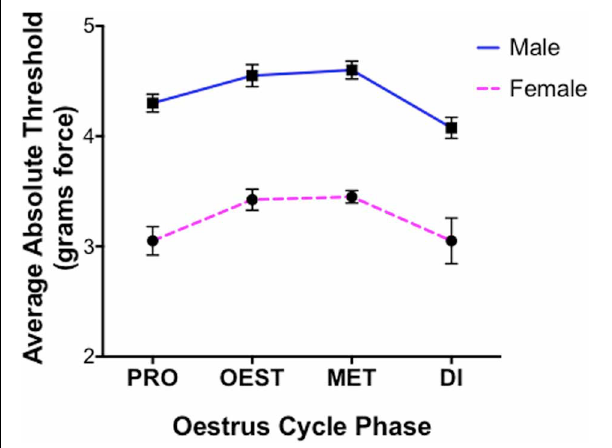
FIGURE 1 | Inability of von Frey method 1 to replicate healthy human pain thresholds. Prior to nerve injury female mechanical allodynia was unable to be appropriately assessed utilizing the common 8-S method (von Frey Test 1). Results demonstrated the inability to distinguish female paw withdrawals indicative of allodynia, or those arising from repeated filament stimulation. Consequently, female rats displayed exceptionally low absolute thresholds compared to males across oestrus cycle phases prior to nerve injury ( t = 14), contrasting healthy human pain thresholds. Assessments were made prior to CCI and behavioral responses were used to calculate absolute threshold (the 50% paw withdrawal threshold) by fitting a Gaussian integral psychometric function using a maximum-likelihood fitting method. A t -value of < − 2 or > 2 was determined statistically significant